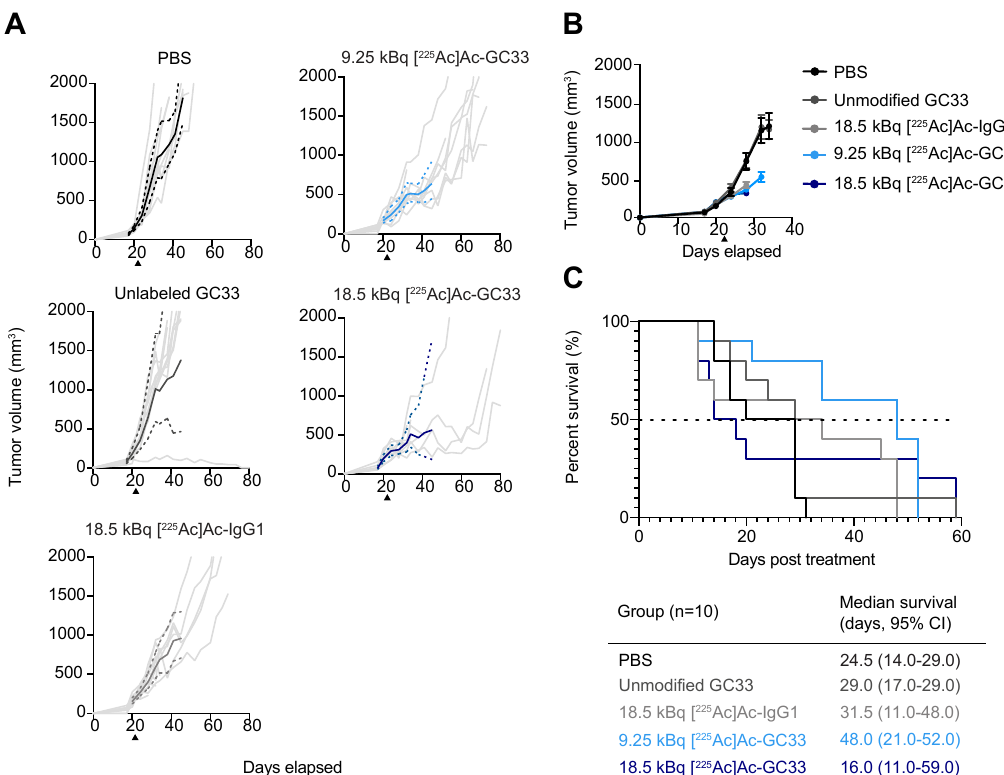
Figure 3. Local control and survival of tumor-bearing mice. ( A ). Spider plots showing the tumor volume of individual mice (light grey), with the mean (bold solid lines) and 95% confidence interval (CI) (dashed lines) of treatment groups over time. ( B ). Mean tumor volumes ± SEM, and ( C ). Kaplan–Meier survival plot. Log-rank test shows survival is